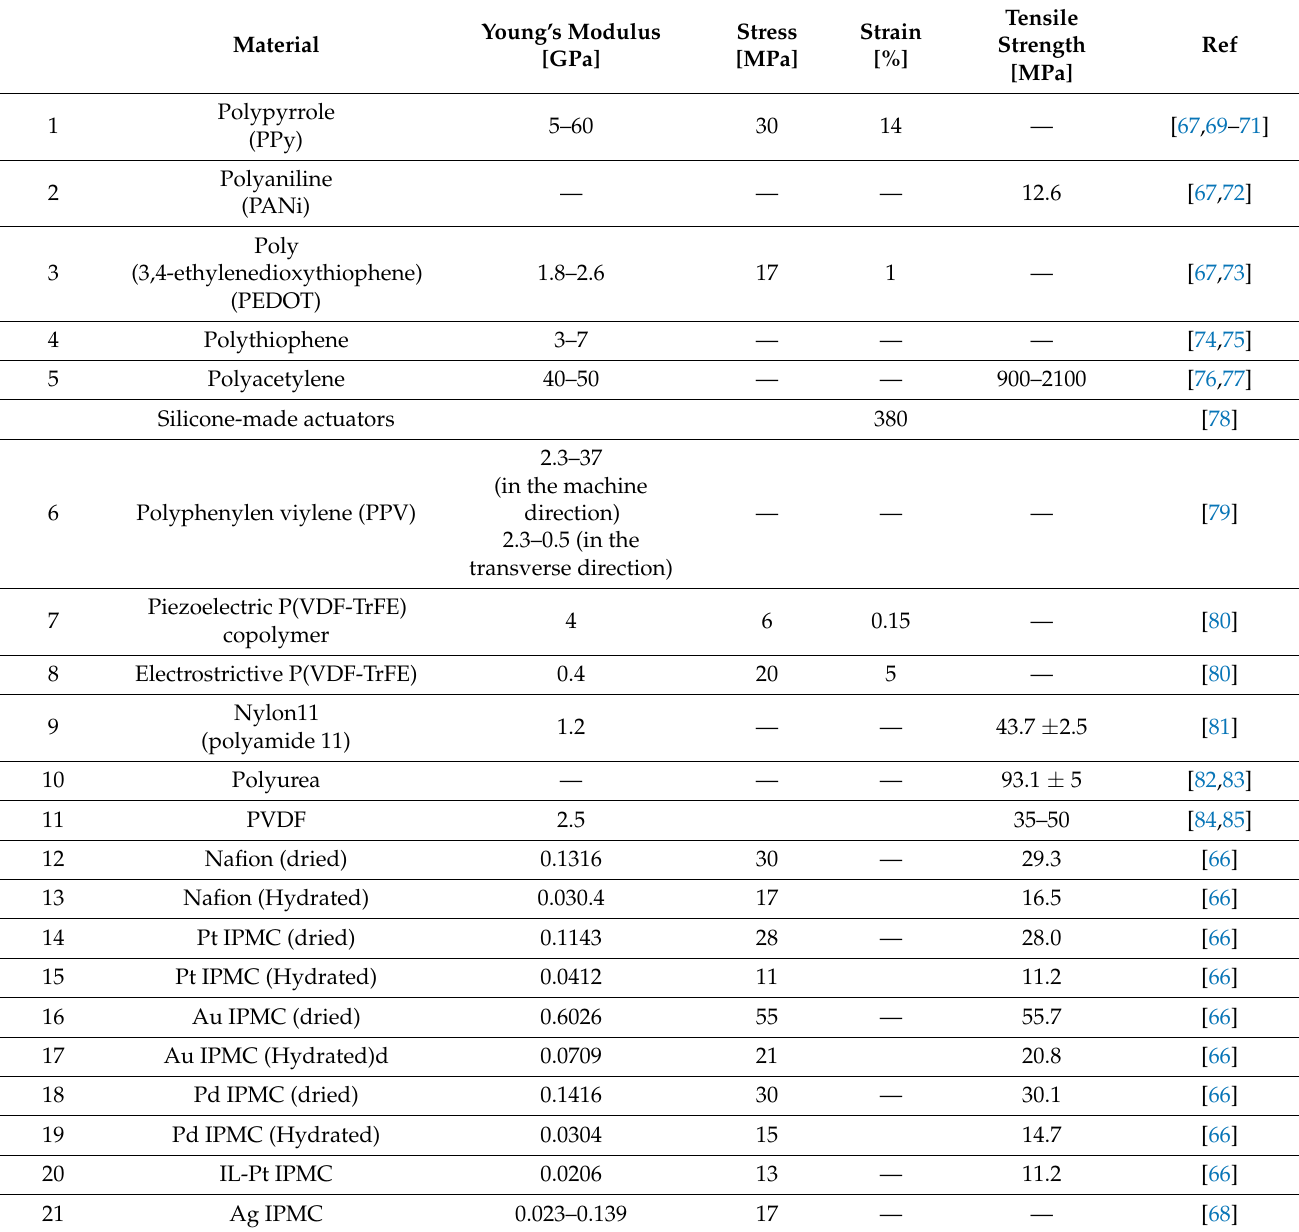
Table 1. The tensile properties of substituted